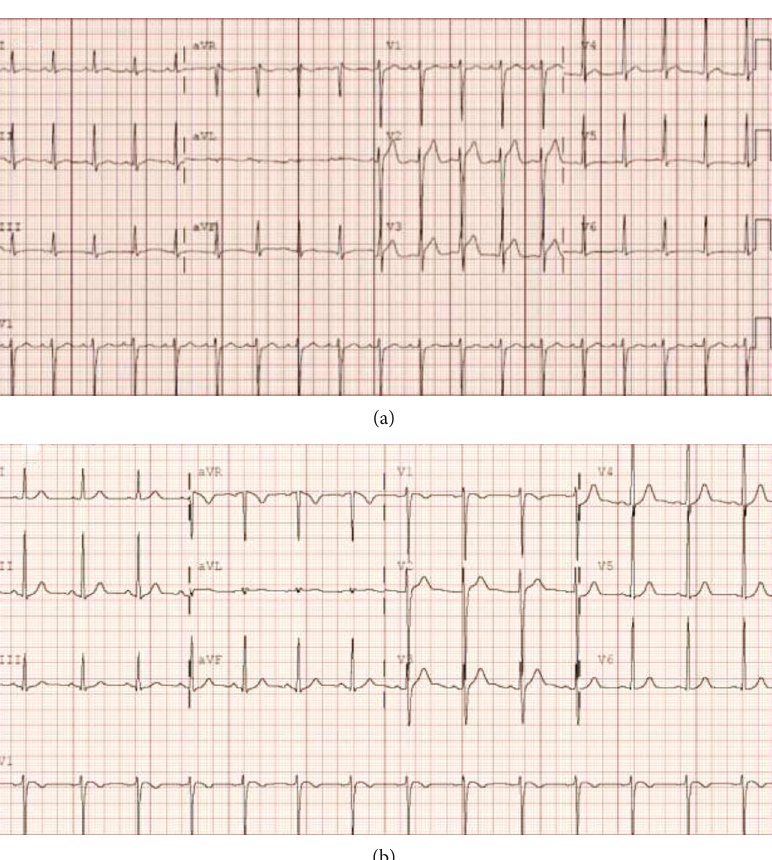
Figure 1: Electrocardiogram on presentation (a) showed sinus tachycardia (heart rate 111 beats per minute), ST elevations most prominent in leads V2-V3 with inferolateral T wave fl attening. Baseline EKG (b) showing less prominent ST elevations in V2-V3 consistent with early repolarization without inferolateral T wave fl attening. Table 1: Lab values at presentation to emergency department and at 7-day follow-up